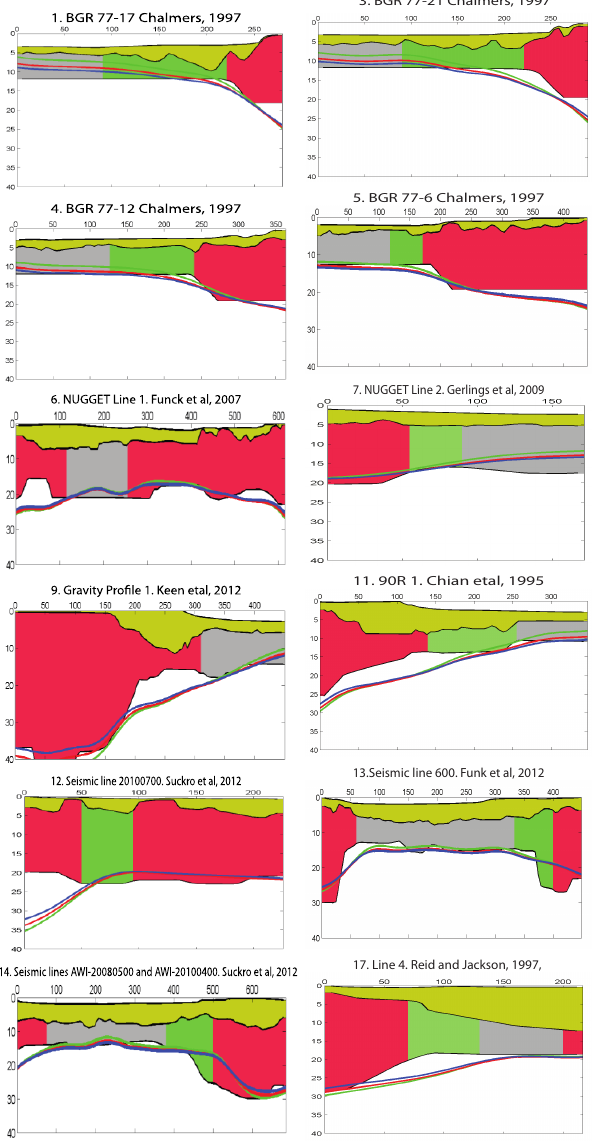
Fig. 5. Seismic profiles showing crustal type interpreted from differ- ent studies, locations shown in Figs. 1 to 4. Red – continental crust; Figure 5. Seismic profiles showing crustal type interpreted from different studies, 950 green – transitional crust; grey – oceanic crust; yellow – sediments. Coloured lines show crustal thickness computed using gravity in- locations shown in Figs. 1 to 4. Red – continental crust, green – transitional crust, grey - 951 version: blue for initial crustal thickness of 37km and density of 500kgm − 3 , red for initial crustal thickness of 38km and density oceanic crust, yellow - sediments. Coloured lines show crustal thickness computed using 952 of 450kgm − 3 , and green for initial crustal thickness of 40km and density of 400kgm − 3 gravity inversion; blue (for initial crustal thickness of 37km and density of 500kg/m3), 953 red (for initial crustal thickness of 38km and density of 450kg/m3) and green (for initial 954 crustal thickness of 40km and density of 400kg/m3). 955